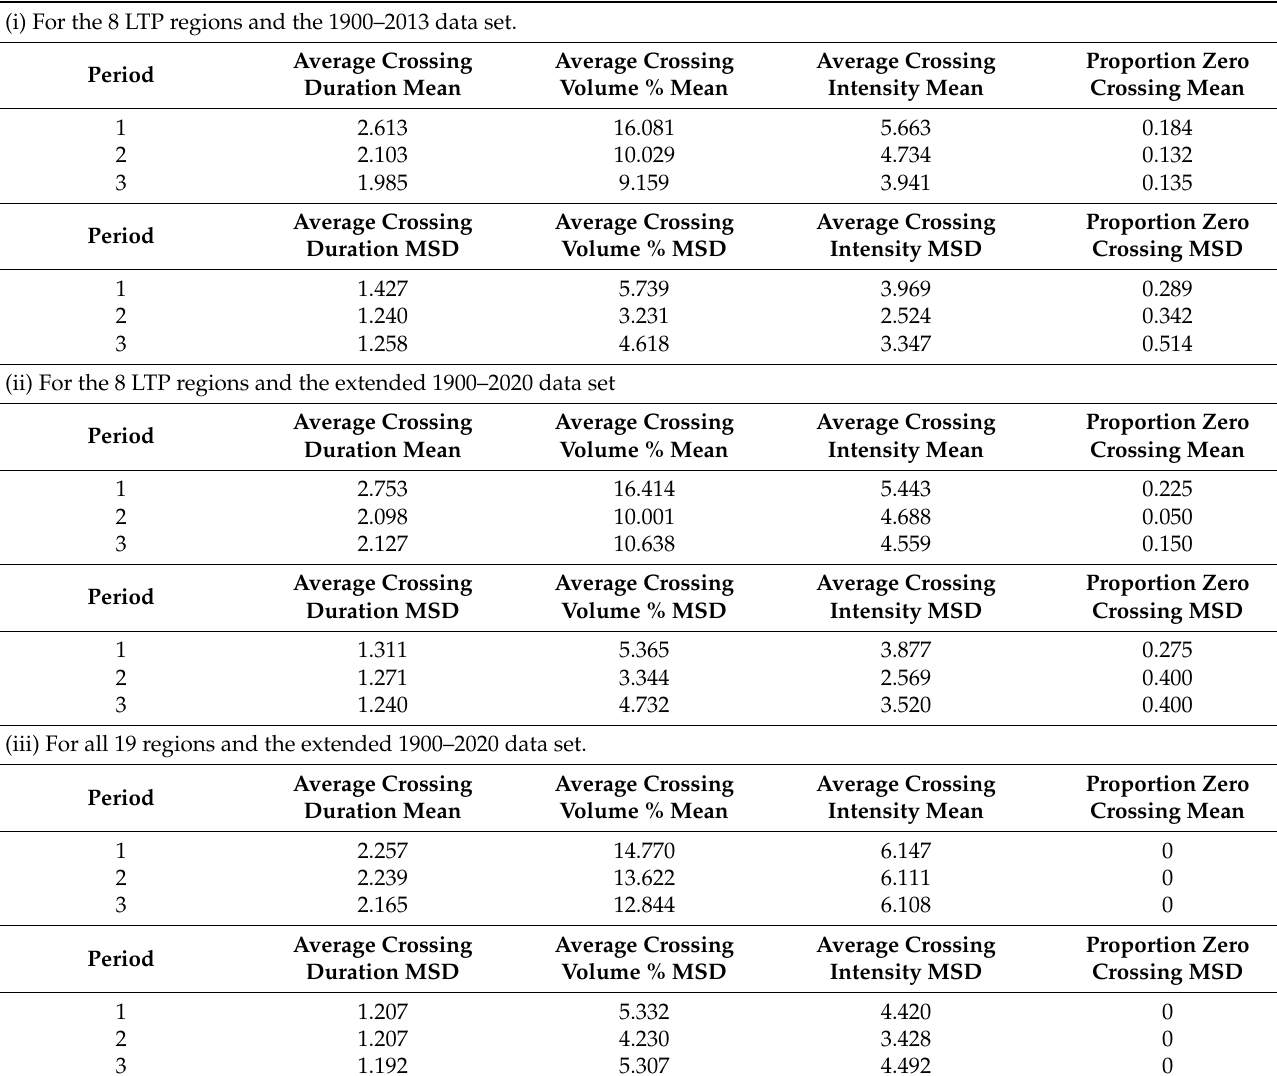
Table 5. Grand averages of the crossing statistics D , SV and I taken across the 8 regions and years for the mean and MSD crossing levels and Periods 1–3. The proportion of years in which no crossing event occurred across the set of regions is also